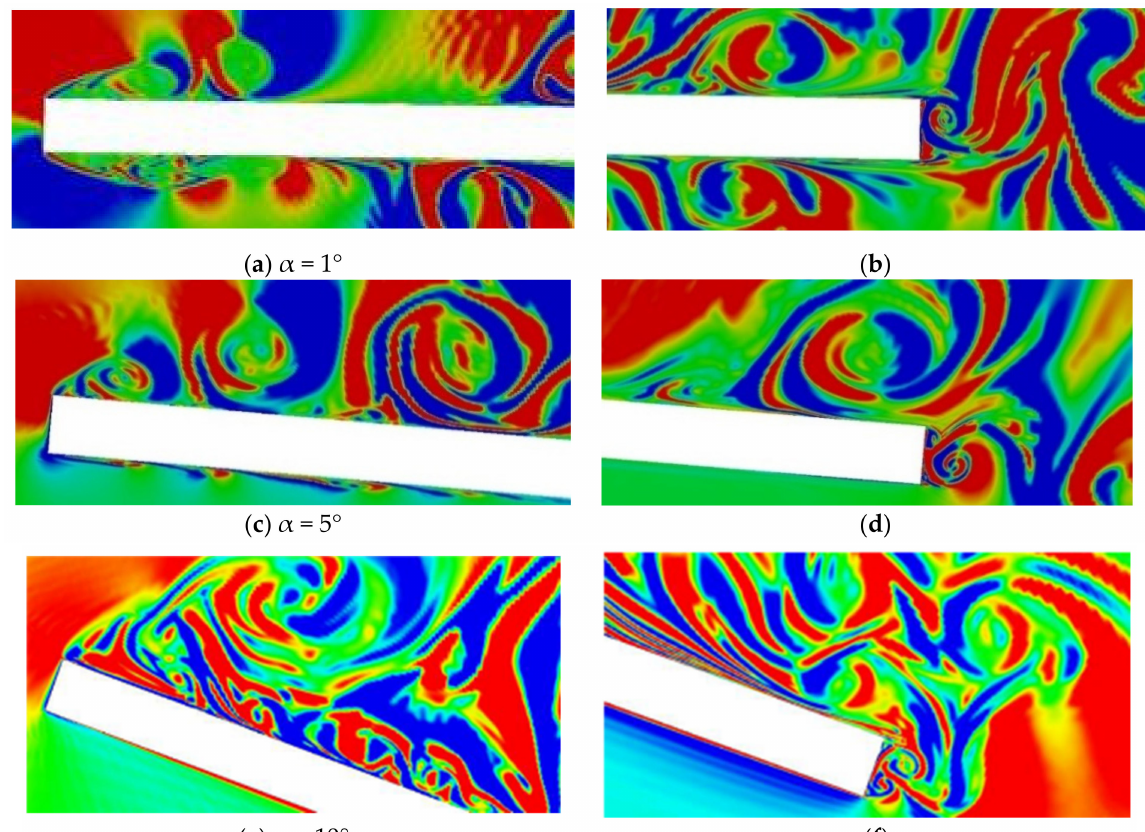
Figure 12. Instantaneous images of horizontal component of density gradient field near leading ( a , c , e ) and trailing edges ( b , d , f ) of tilted plate ( T b = 5.25 s, N = 1.2 s − 1 , L = 10 cm, U = 100 cm/s): lines ( a – c )— α = 1 ◦ , 5 ◦ , 10 ◦ , red and blue colors correspond to positive and negative values of the perturbation fields, and green color is zero